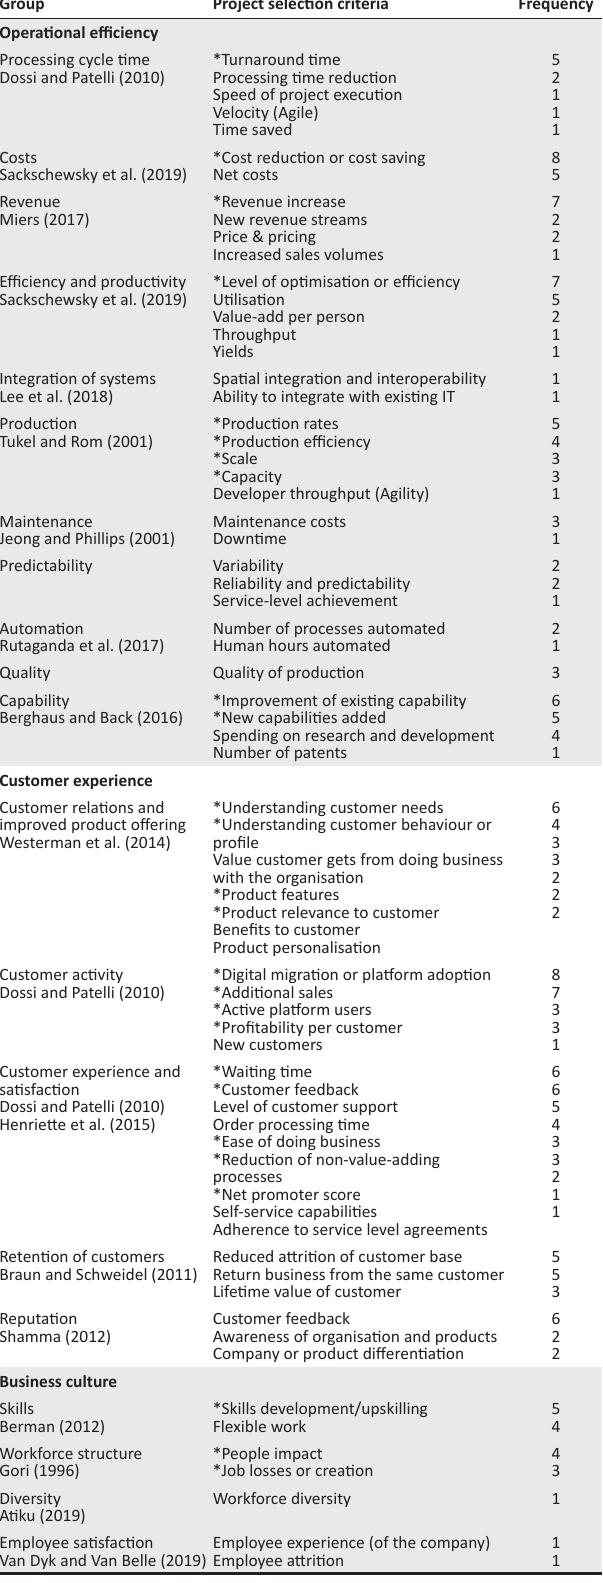
Table A-1: Project selection criteria from interviewees. Group